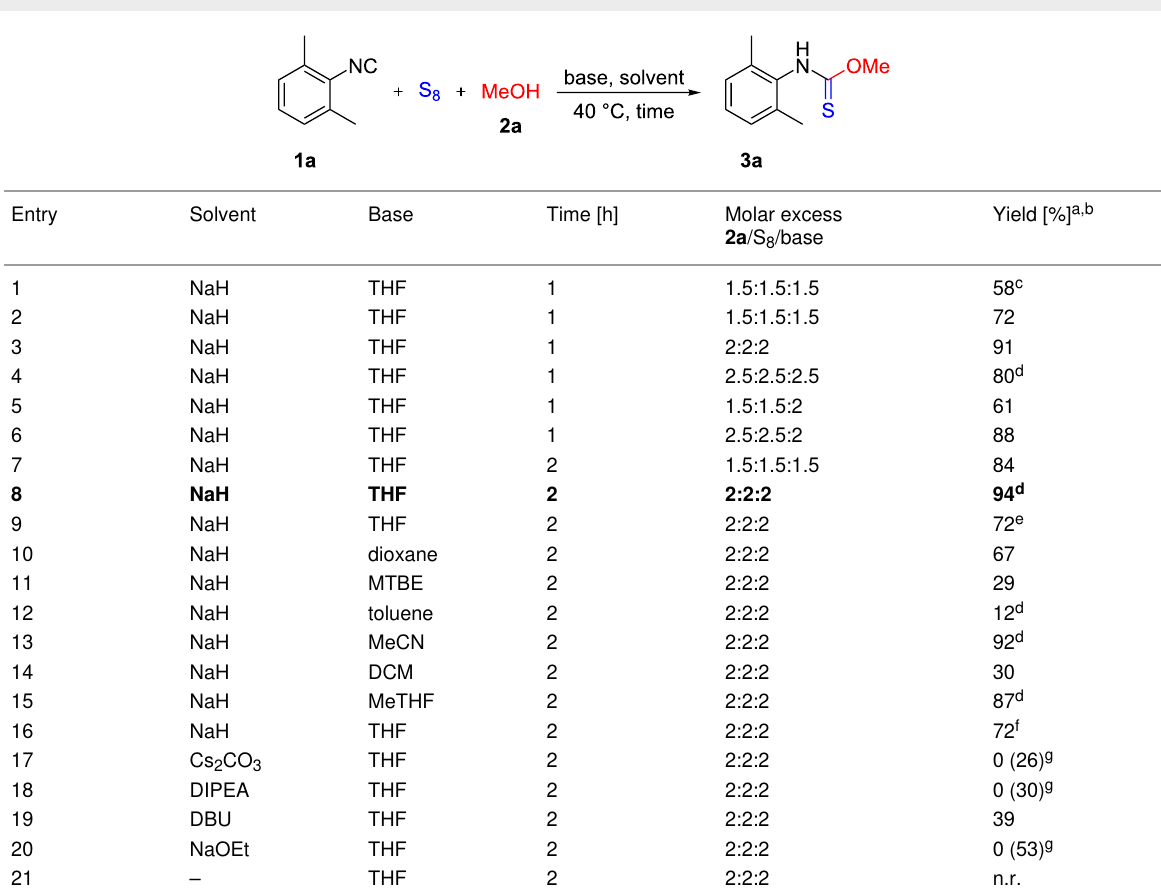
Table 1: Optimization of the reaction conditions for the synthesis of O -thiocarbamates.